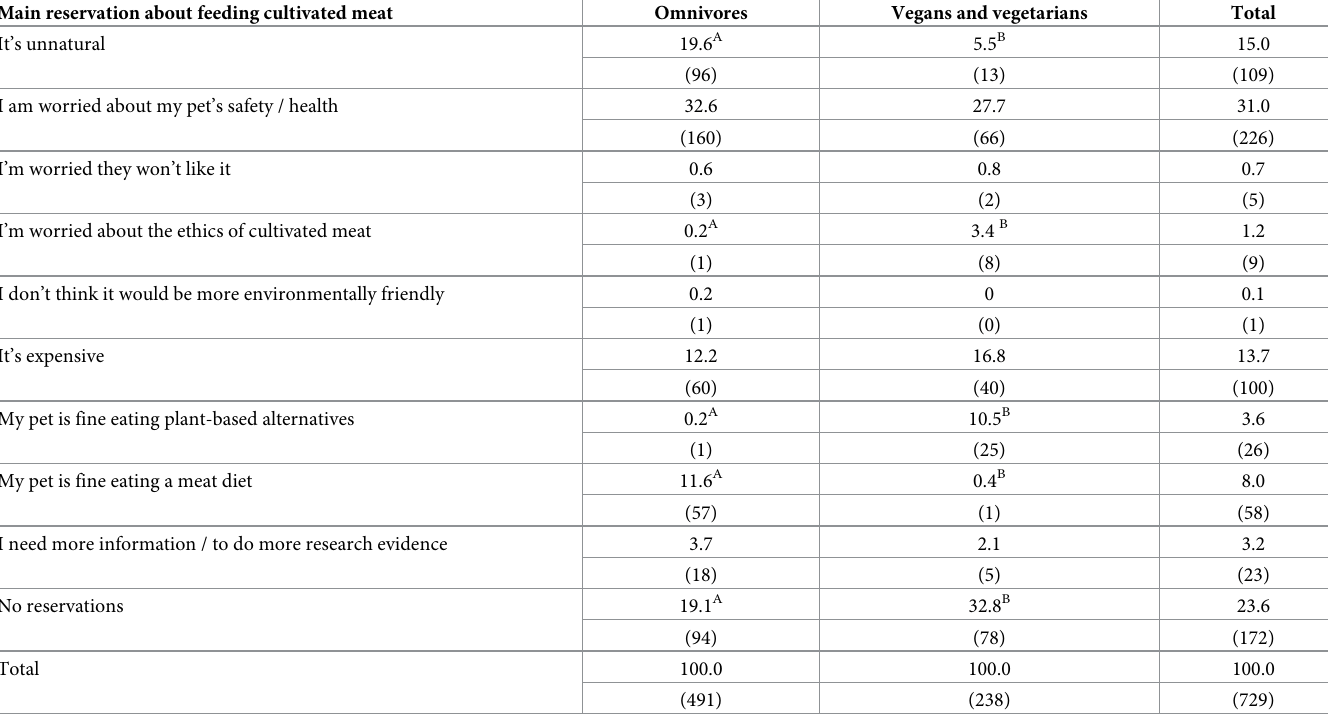
were ‘fine’ eating plant-based pet food was their main reservation, while omnivores were more likely to report that their main reservation was that they were happy to keep feeding conven- tional pet food. This is consistent with the expectation that respondents are more likely to feed their animal in accordance with their own diet, and to be more likely to see this diet as appro- priate for their pets. While other differences between omnivores and vegans/vegetarians existed, they were not statistically significant. Respondents who identified the naturalness of meat-based pet food as their primary worry about switching to plant-based pet food were also the ones most likely to report cultivated meat’s unnaturalness as a primary concern, with 29.4% of them choosing unnaturalness of cul- tivated meat as their biggest reservation for this type of diet (Fig 7). This is interesting because Table 8. Main reservations about feeding a cultivated diet to pets, by respondents’